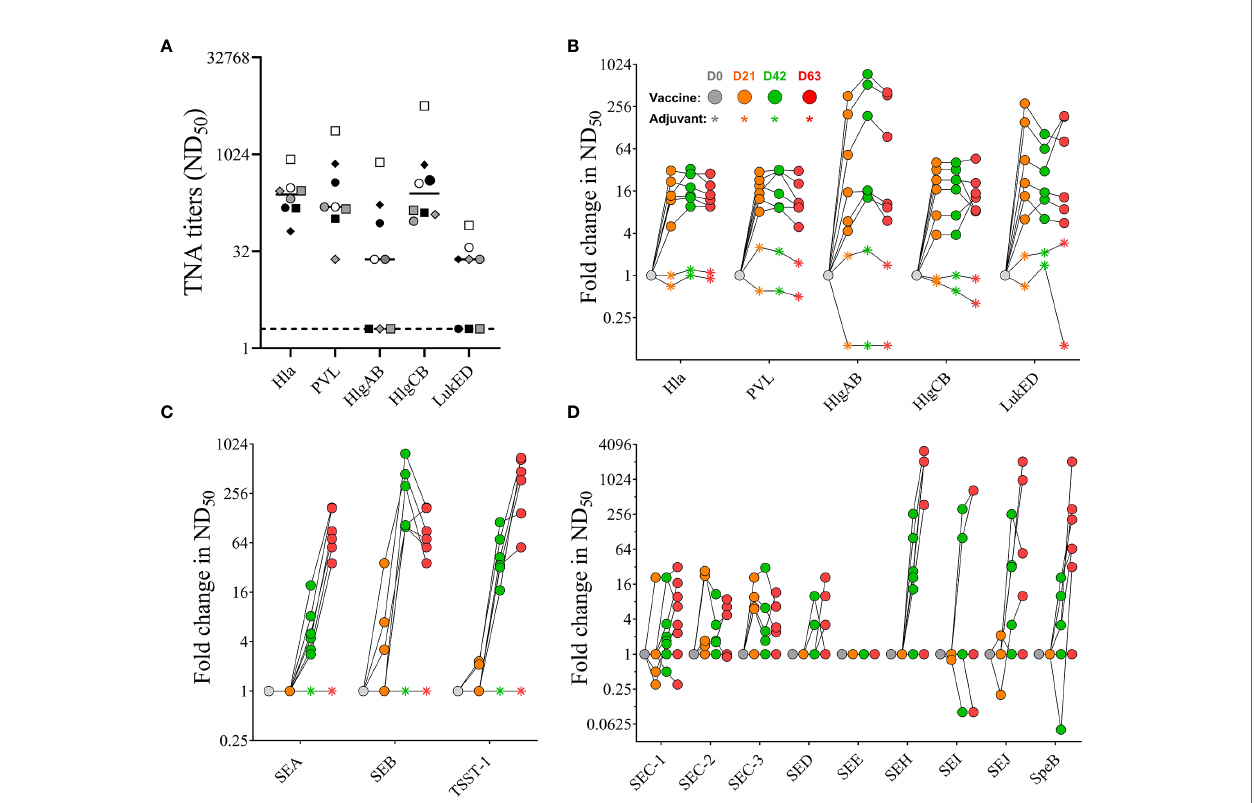
FIGURE 6 | Serum toxin neutralizing antibody titers. Pre-existing neutralizing titers measured in serum samples before vaccination. Dotted lines indicate limit of detection set at 2, the lowest serum dilution tested in the assay (A) . Fold increase in Toxin neutralizing activity (TNA) and cross-neutralizing activity of non-human primate (NHP) sera collected on days 0, 21, 42, and 63 measured toward wildtype pore-forming toxins Hla, PVL, HlgAB, HlgCB, and LukED (B) and superantigens SEA, SEB, and TSST-1 (C) , as well as SEC-1-3, DED, SEE, SEH, SEI, and SEJ (D) . Colored symbols re fl ect indicated days post vaccination. Data was analyzed with GraphPad PRISM